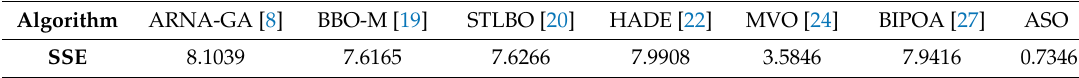
Figure 8. SSE convergence for the 250 W stack. Table 5. 250 W PEM fuel cell stack.